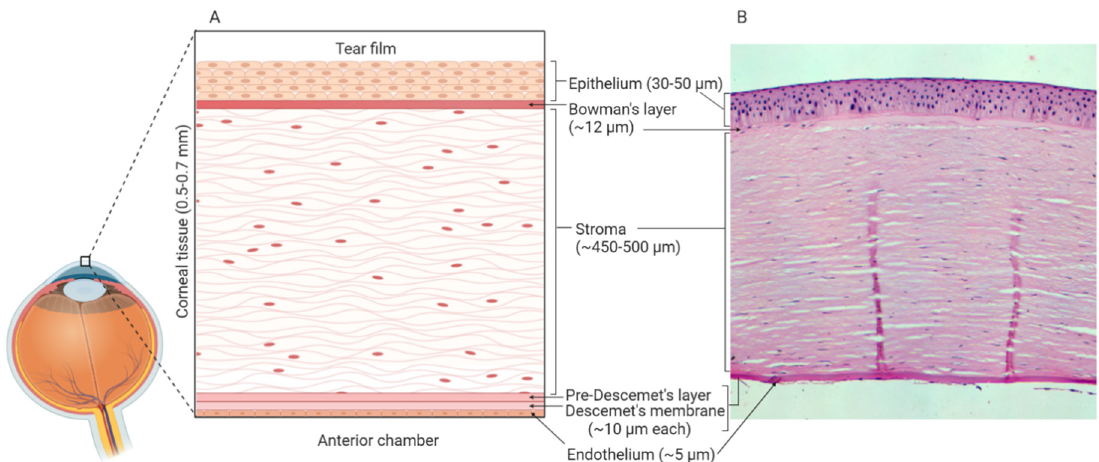
Figure 2. Human corneal layers: ( A ) Schematic representation, and ( B ) haematoxylin and eosin staining. The cornea has six distinct layers and the outermost layer is the corneal epithelium, which is made up of 5-7 rows of tightly packed corneal epithelial cells. These cells lie on an acellular, collagenous layer named the Bowman’s layer and together the epithelium and the Bowman’s layer are essential in the protection of the underlying stromal tissue. The stroma constitutes 90% of the overall thickness of the cornea and is composed of mainly type I collagen and differentiated keratocytes. Beneath the stroma is the Pre-Descemet’s layer (also known as Dua’s layer) and the Descemet’s membrane. These collagen-rich, acellular layers separate the stromal tissue from the endothelium. The endothelium is composed of a single layer of cells, which are mainly hexagonal in shape. This layer is adjacent to the anterior chamber and constitutes the final layer of the cornea. Created with Biorender.com.